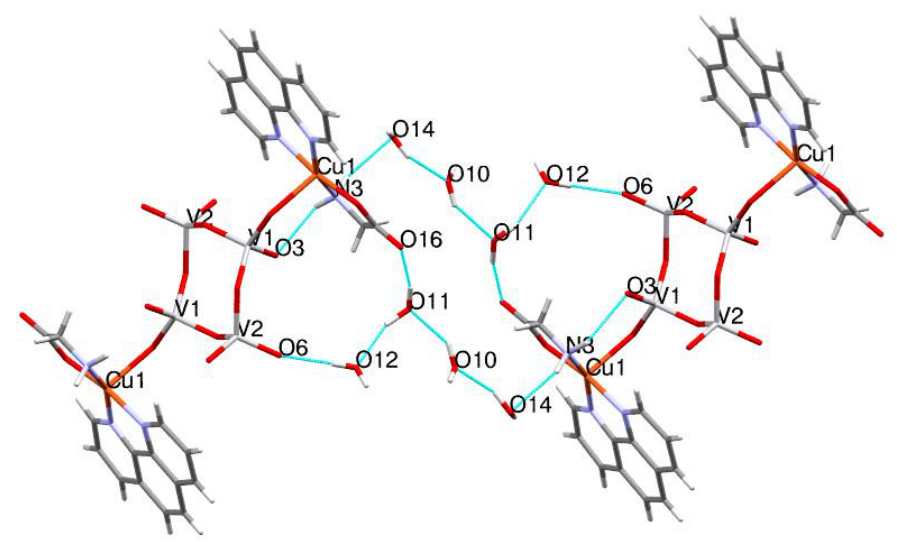
arrows point to truly intramolecular hydrogen bonds. point to truly intramolecular hydrogen bonds.